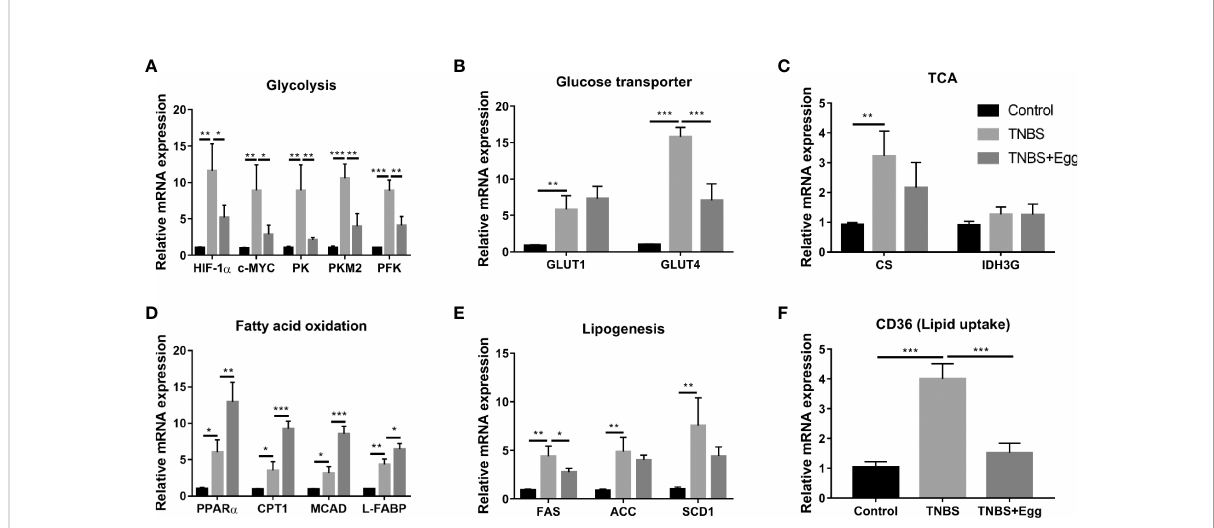
FIGURE 6 Pre-exposure to S. japonicum eggs led to reprogramming of glucose and lipid metabolism in colon tissue from mice with experimental colitis. The relative mRNA expression levels of genes related to glycolysis (A) , glycose transporters (B) , TCA (C) , fatty acid oxidation (D) , lipogenesis (E) , and lipid uptake (F) in colon tissues were evaluated by RT-PCR. Data are expressed as means ± SEMs based on 6 samples in each group and from 2 independent experiments. Asterisks mark signi fi cant differences among different groups (* P < 0.01, ** P < 0.01, ***P <